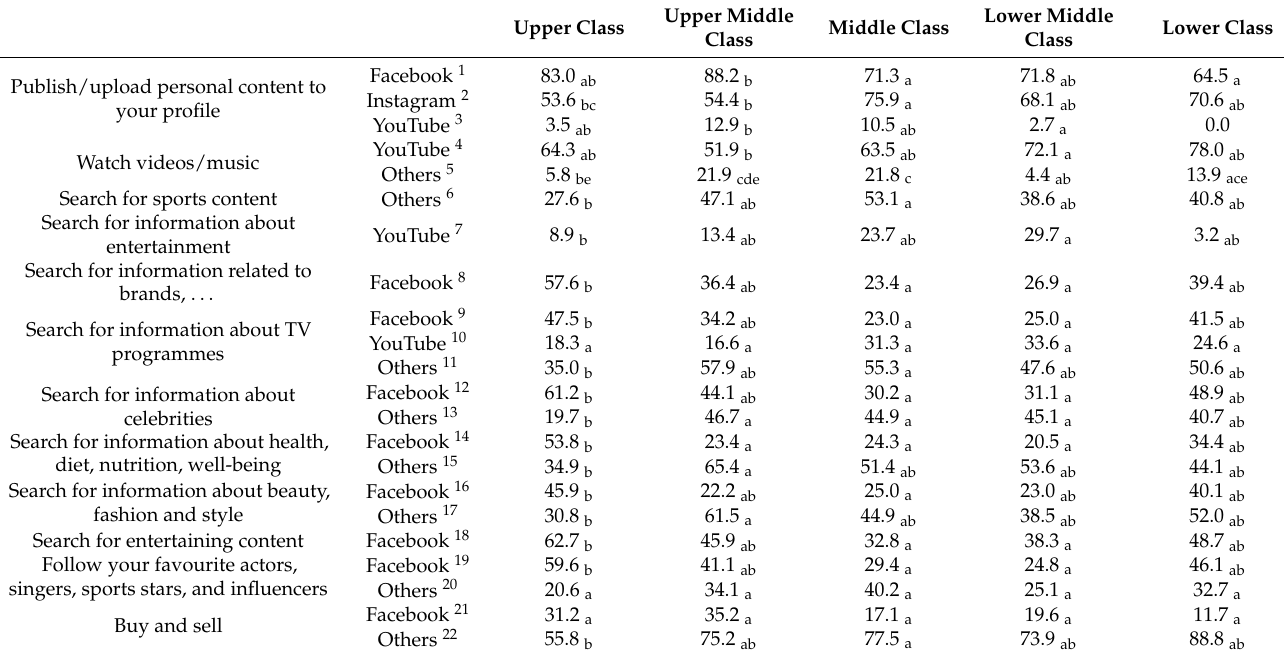
Table 5. Use of social networks by young people from 17 to 24 years of age in the Autonomous Region of Madrid, according to social class. In